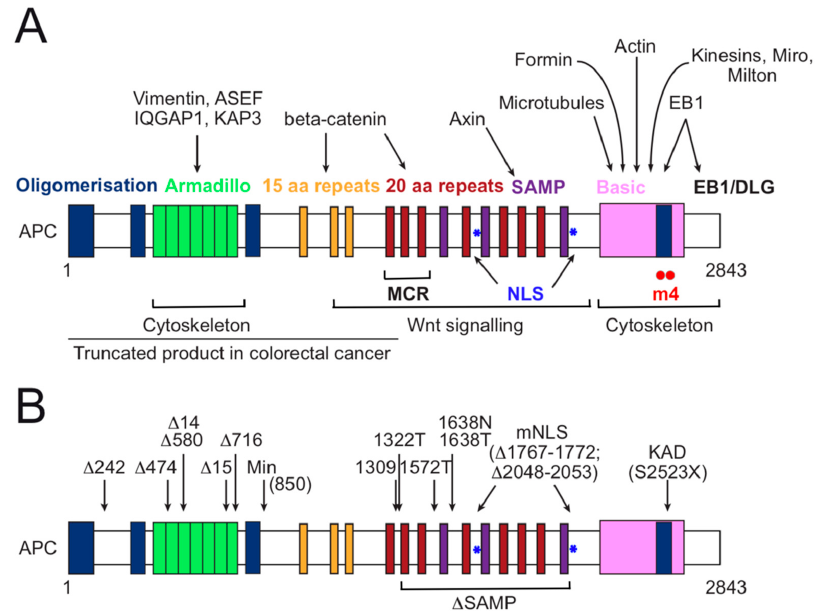
Figure 3. Human APC protein structure and sites (mutated or truncated) in murine models. ( A ) Schematic showing the position of APC domains (coloured boxes and asterisks) (from left to right): Oligomerisation, Armadillo repeats, 15 and 20 amino acid repeats, Serine ‐ Alanine ‐ Methionine ‐ Proline (SAMP) motifs, nuclear localisation signal motifs (NLS), basic domain (which contains one oligomerization domain shown in blue), and the end ‐ binding protein (EB1)/discs large (DLG) domain. Arrows link APC partners to the corresponding interaction sites. The mutated cluster region (MCR) corresponds to amino acids 1284 to 1580. Blue asterisks indicate the location of the two NLS, which comprise to amino acids 1767 ‐ 1772 and 2048 ‐ 2053. Red dots indicate the location of the APC ‐ m4 mutation (L2539A I2541A) in the oligomerization motif within the basic domain. In most colon cancers, mutations lead to a truncated product lacking both signalling and cytoskeletal functions. ( B ) Schematic indicating the position of the germline Apc mutations in various murine models. The names of the mutations refer to the common name used to describe a particular murine cancer model. Δ indicates deletion; AA, amino acid (number in the sequence and change); Min (Multiple intestinal neoplasia), mNLS (mutant in nuclear localisation signals), KAD (Kyoto Apc Delta). The central region (amino acids 959–2129) has been extensively studied because it is critical to down ‐ regulate the Wnt signalling pathway [29,30,58,142,165,166]. APC forms together with Axin the core of the so ‐ called beta ‐ catenin destruction complex [167], which phosphorylates beta ‐ catenin,